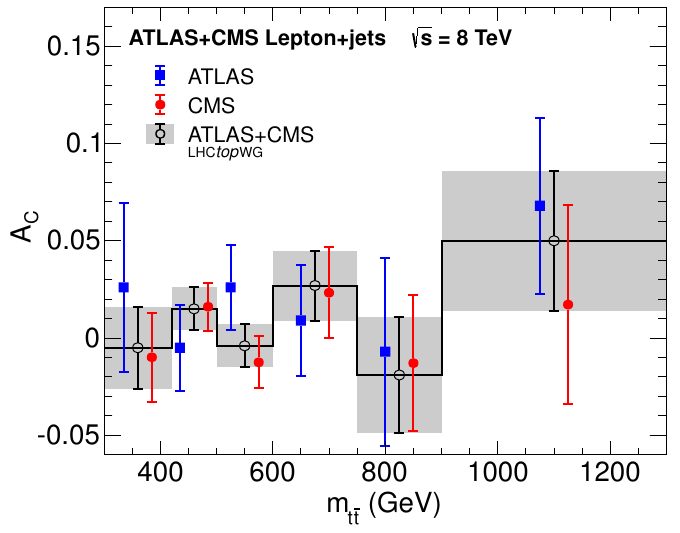
Figure 3 . Measured inclusive charge asymmetry A C at the LHC at versus forward-backward asymmetry A FB (vertical lines) at the Tevatron [3], compared with the SM prediction at QCD NNLO (+EW NLO) [20{22] and predictions incorporating various potential BSM contributions [66, 67]: a W 0 boson, a heavy axigluon ( G (cid:22) ), a scalar isodoublet ( (cid:30) ), a colour triplet scalar ( ! 4 ), and a colour sextet scalar ((cid:10) 4 ).